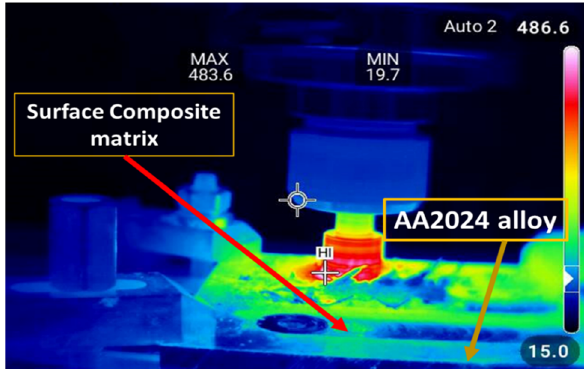
Figure 3: Typical thermographic image of the fabricated surface composite using